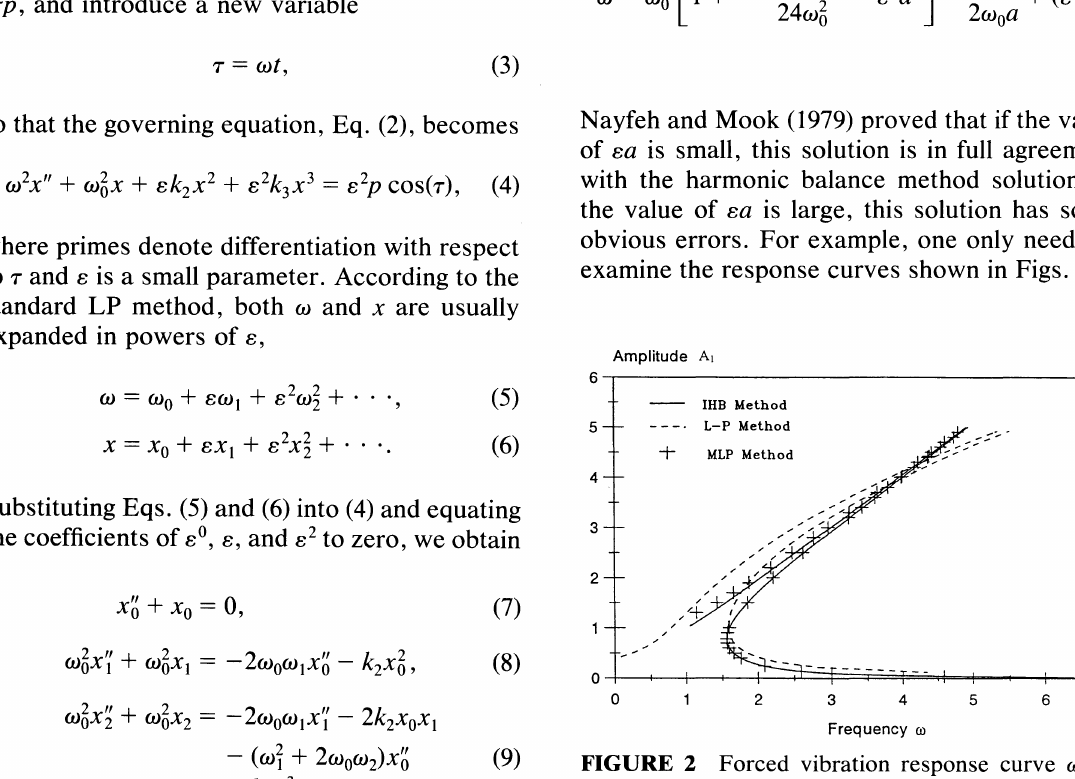
FIGURE 1 Free vibration response curve w-A I for e = 1, Wo = 1, k z = 0.8, k3 = 1.2, and p = o.